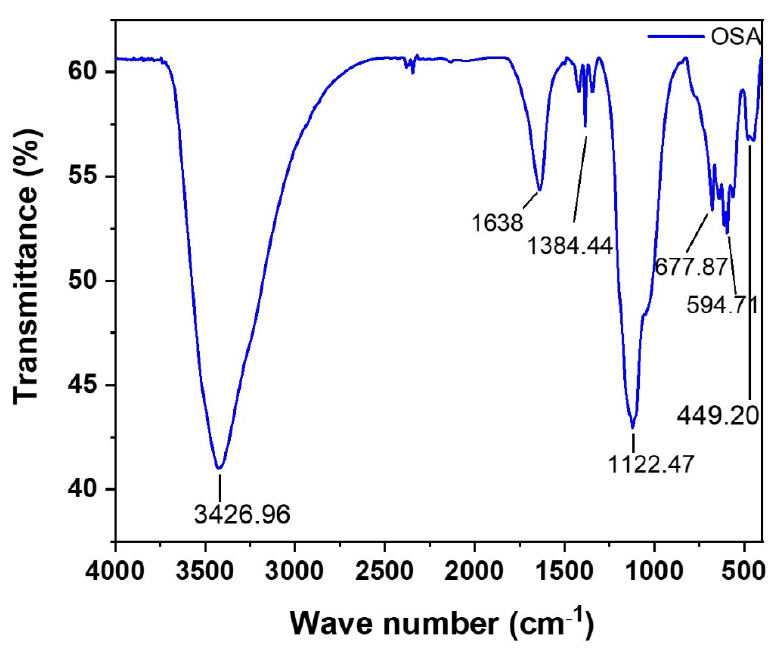
Figure 5. Oily sludge ash FTIR. Table 5. Chemical composition of OPC and OSA.